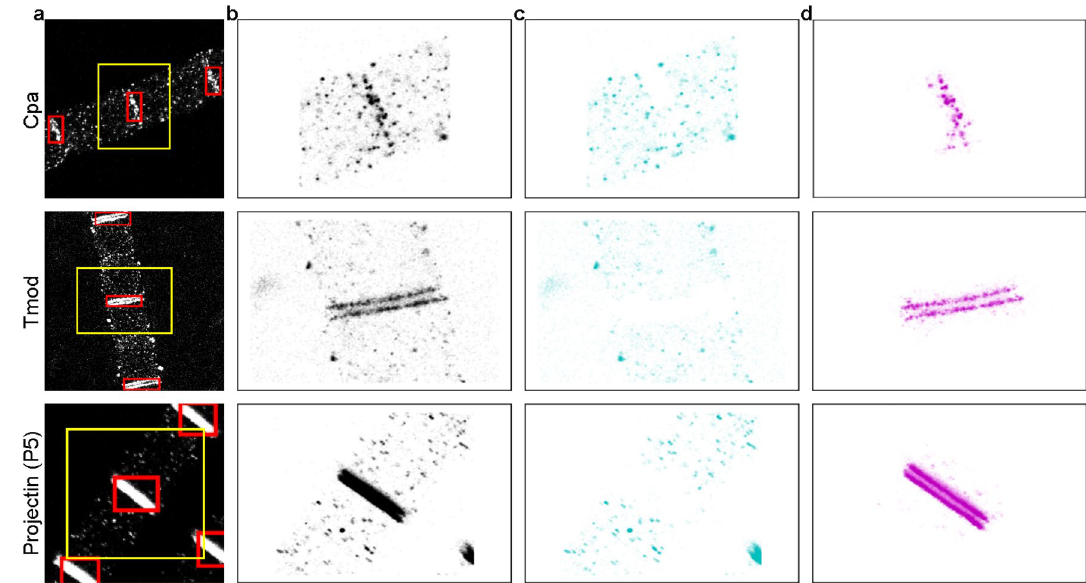
Figure 2. The selection of double-line localizations. ( a ) The pixelated images and the detected double-line objects (red boxes) and analyzed areas (yellow boxes) for three different proteins ( Cpa Capping protein alpha, Tmod Tropomodulin and Projectin (P5)). ( b ) Localization coordinates in the analyzed areas are marked with yellow boxes in ( a ). ( c ) Localization coordinates classified by the algorithm as noise in the given areas (yellow boxes in ( a )). ( d ) Localization coordinates that the algorithm has assigned to double-line objects in the given areas. Coordinates marked with pale violet have been filtered out